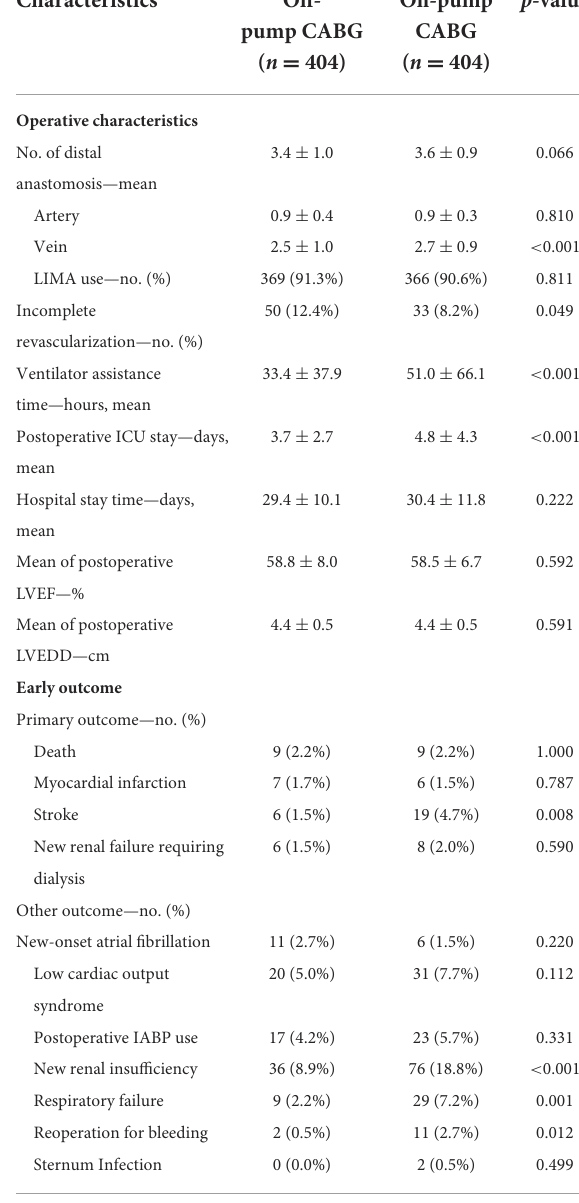
TABLE 4 Operative characteristics and early outcome of the patients after matching.